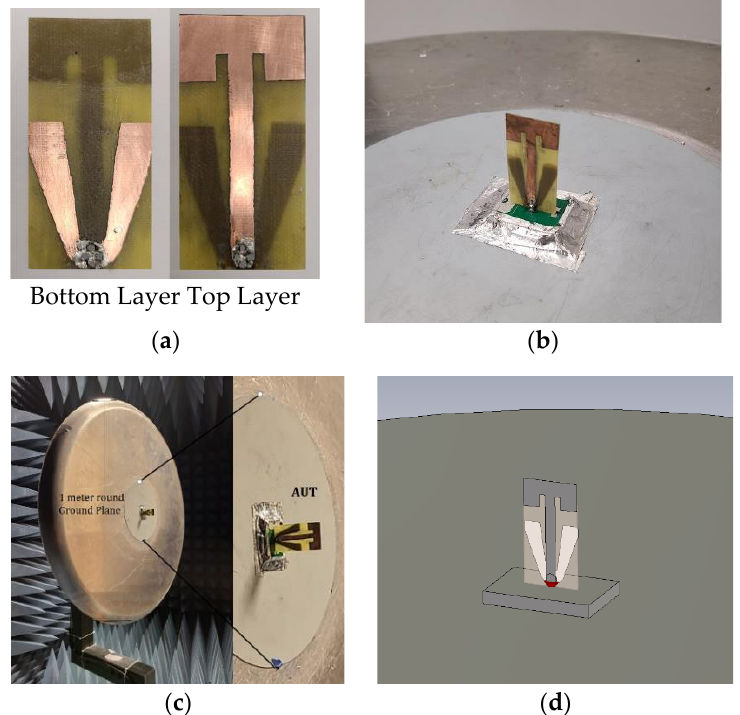
Figure 13. ( a ) Fabricated antenna; ( b ) antenna prototype; ( c ) antenna measurement setup; ( d ) simulation model.